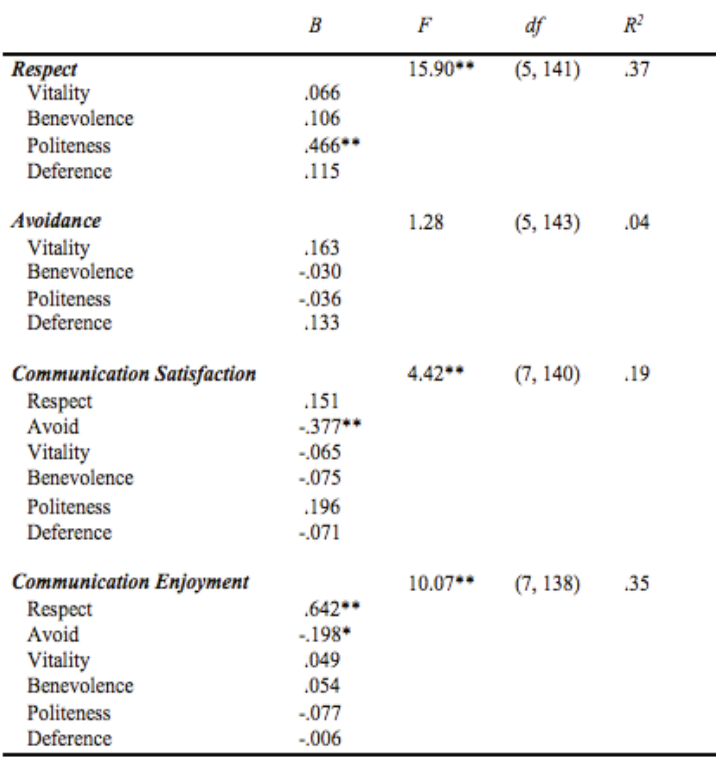
Regression Results for Mongolia Data (Older Adult